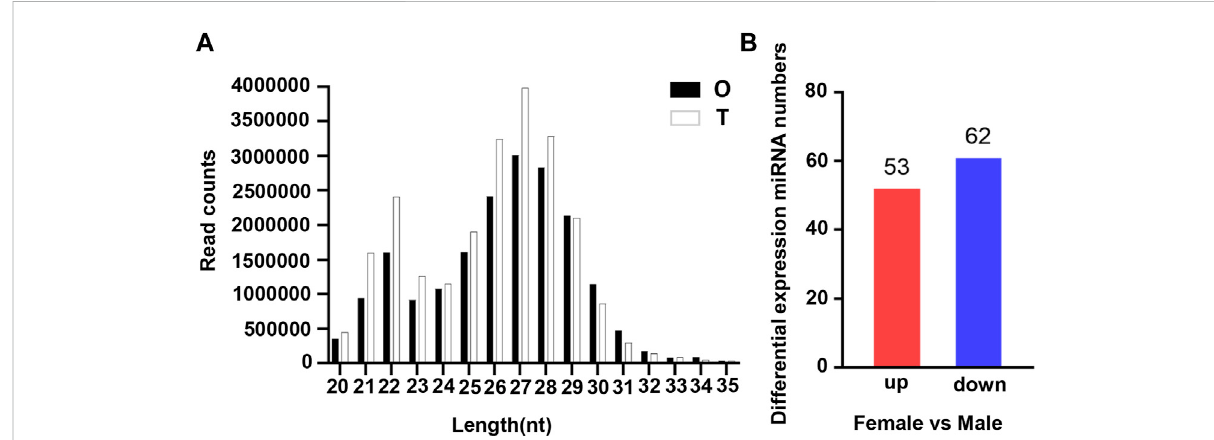
FIGURE 1 Characterization of miRNA in the gonads of O. bidens . (A) Length distribution of clean reads. The X axis shows the length of clean reads. The Y axisshows thereadcounts. (B) Statistic ofDEmiRNAs. The X axisshowsthecomparisongroups;The Y axisshowsthenumberofdifferentialmiRNAs in the comparison group, respectively. Red represents up-expressed miRNAs; blue represents down-expressed miRNAs.